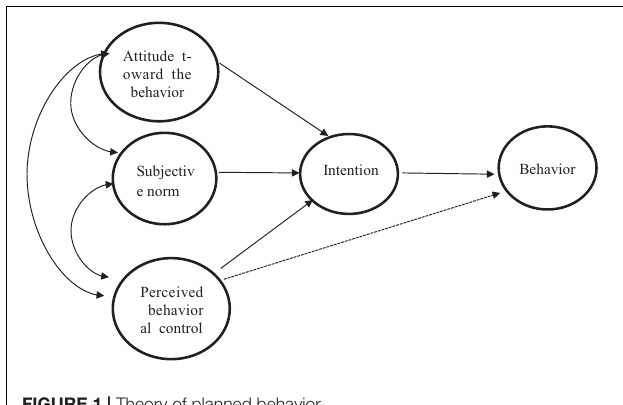
FIGURE 1 | Theory of planned behavior.